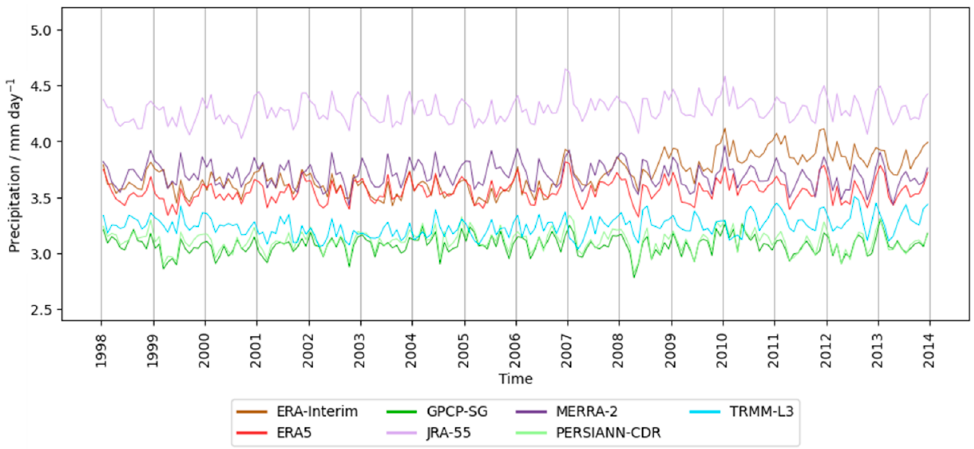
Figure 7. Same as Figure 6a but for the shorter time period 1998–2013 for which TRMM ‐ L3 data are available.